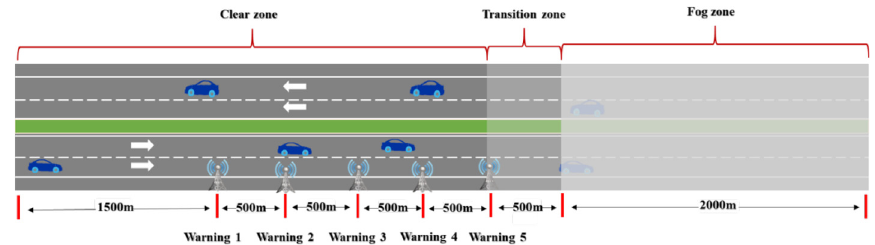
Figure 5 Layout of the experimental